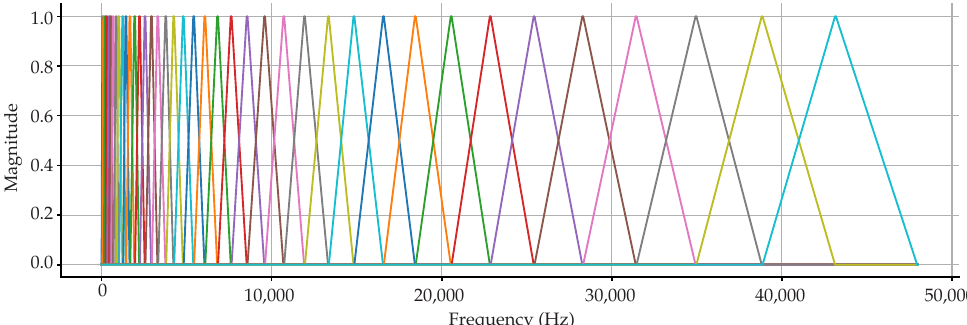
Figure 2. Uniform Mel-bandwidth filterbank for a 96 k sample